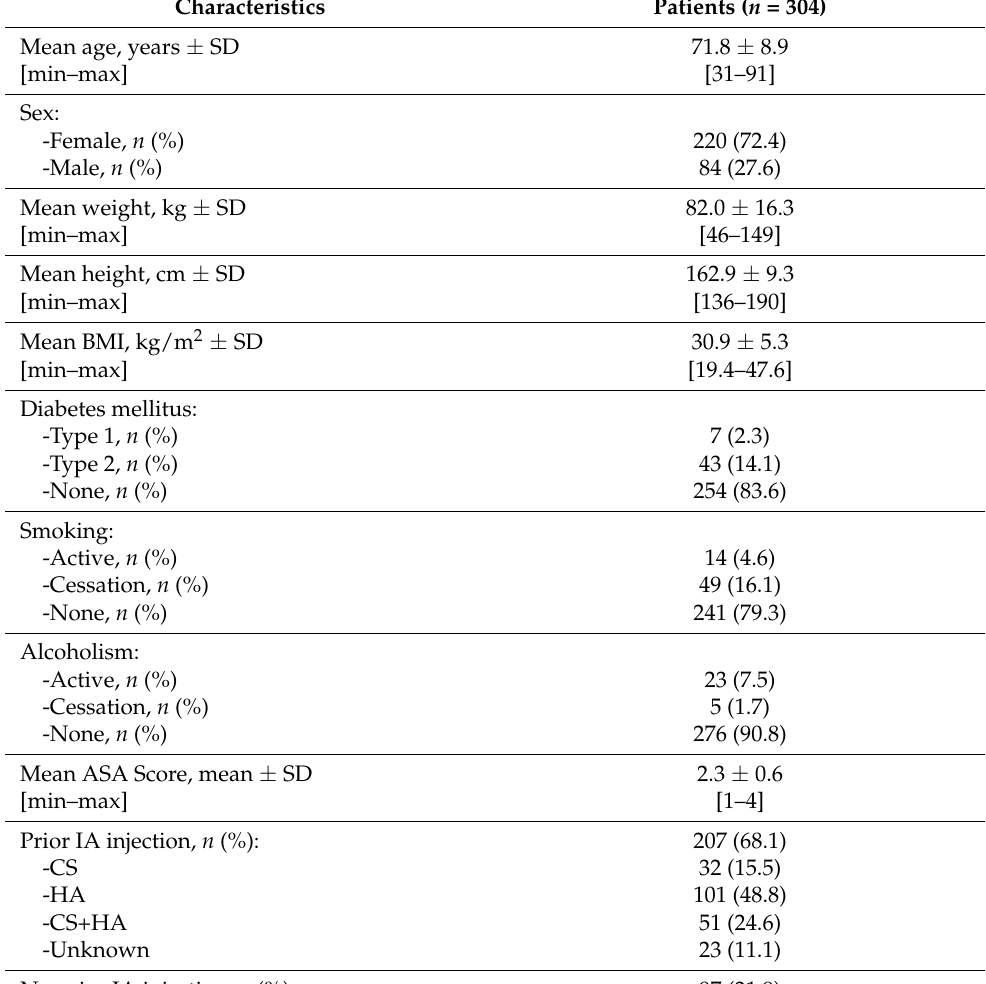
Table 1. Demographic characteristics.